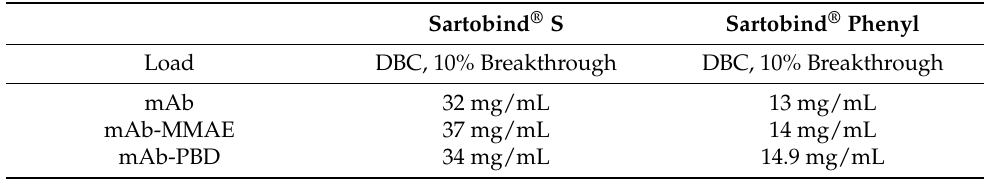
Figure 1. Membrane dynamic binding capacity at 10% breakthrough. ( A ) Sartobind ® S, 3 mL, 8 mm bed height with mAb, mAb-MMAE, and mAb-PBD conjugates. ( B ) Sartobind ® Phenyl, 3 mL, with mAb, mAb-MMAE, and mAb-PBD conjugates. Protein samples were diluted as 1.0 mg/mL with 20 mM MES, pH 6.0. Table 1. Membrane dynamic binding capacity.